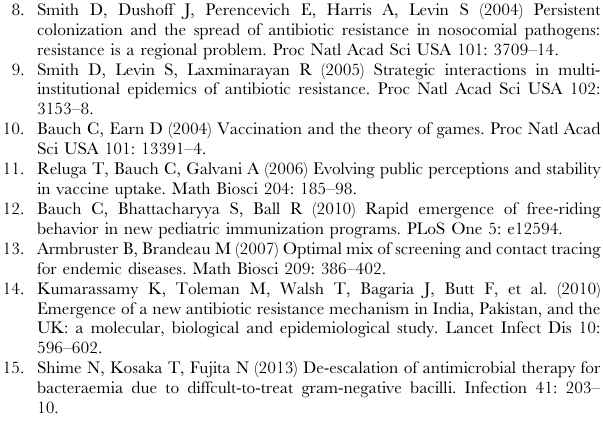
different values of r when M ~ 2 (solid line) and M ~ 10 (dashed line) at both t ~ 3 (left) and t ~ : 01 (right). These figures continue to demonstrate that units of cost are arbitrary and the best response curve is affected by the ratio of prevalence costs, c , to screening and treatment costs, C S and C T . Figure S18 Sensitivity analysis of M across parameter space for parameters of the transmission function. Across the range of values explored for the parameters of the transmission function, K 1 , K 2 , and K 3 , a lower level of screening autonomy M was associated with an upward shift of the best response curve and a higher equilibrium screening level. For parameters of the transmission function, best response curves are shown for different values of r when M ~ 2 (solid line) and M ~ 10 (dashed line) at both t ~ 3 (left) and t ~ : 01 (right). Figure S19 Sensitivity analysis of M across parameter space for r . Across the range of values explored for r , a lower level of screening autonomy M was associated with an upward shift of the best response curve and a higher equilibrium screening level. Best response curves are shown for different values of r when M ~ 2 (solid line) and M ~ 10 (dashed line) at both t ~ 3 (left) and t ~ : 01 (right). Figure S20 Sensitivity analysis of M across parameter space for z t ~ 0 . Across the range of values explored for z t ~ 0 , a lower level of screening autonomy M was associated with an upward shift of the best response curve and a higher equilibrium screening level. Best response curves are shown for different values of z t ~ 0 when M ~ 2 (solid line) and M ~ 10 (dashed line) at both t ~ 3 (left) and t ~ : 01 (right). Figure S21 Multivariate sensitivity analysis across parameter space for l and K 2 . Values for the two parameters primarily associated with affecting the disease reproductive ratio, namely l and K 2 , were varied simultaneously. Our two primary findings were consistent across the values explored in this multivariate analysis: (1) a lower level of screening autonomy M was associated with an upward shift of the best response curve, and